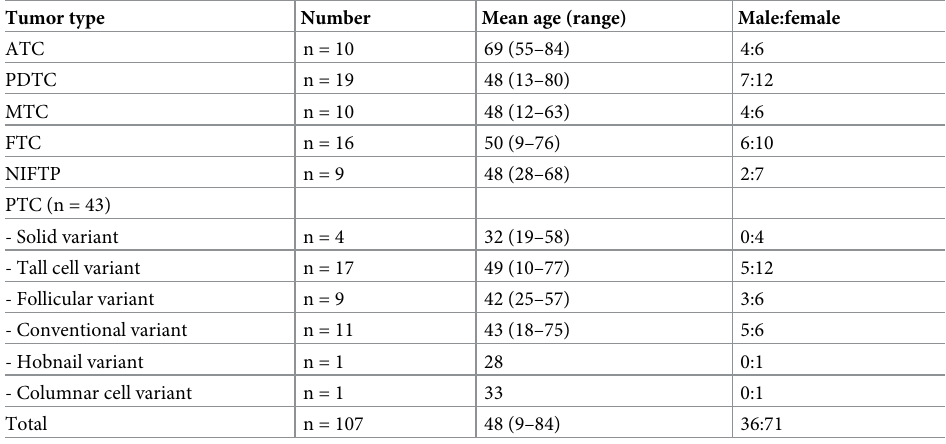
Table 1. Patient’s characteristics: Number of cases, mean age and sex of each group of patients. Tumor